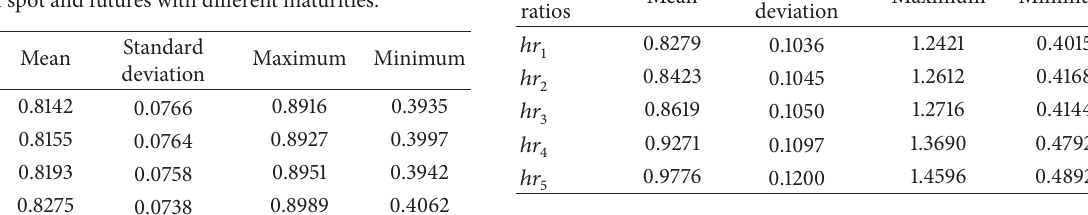
Table 3: Statistical description of conditional correlation coeffi- cients between spot and futures with different maturities.